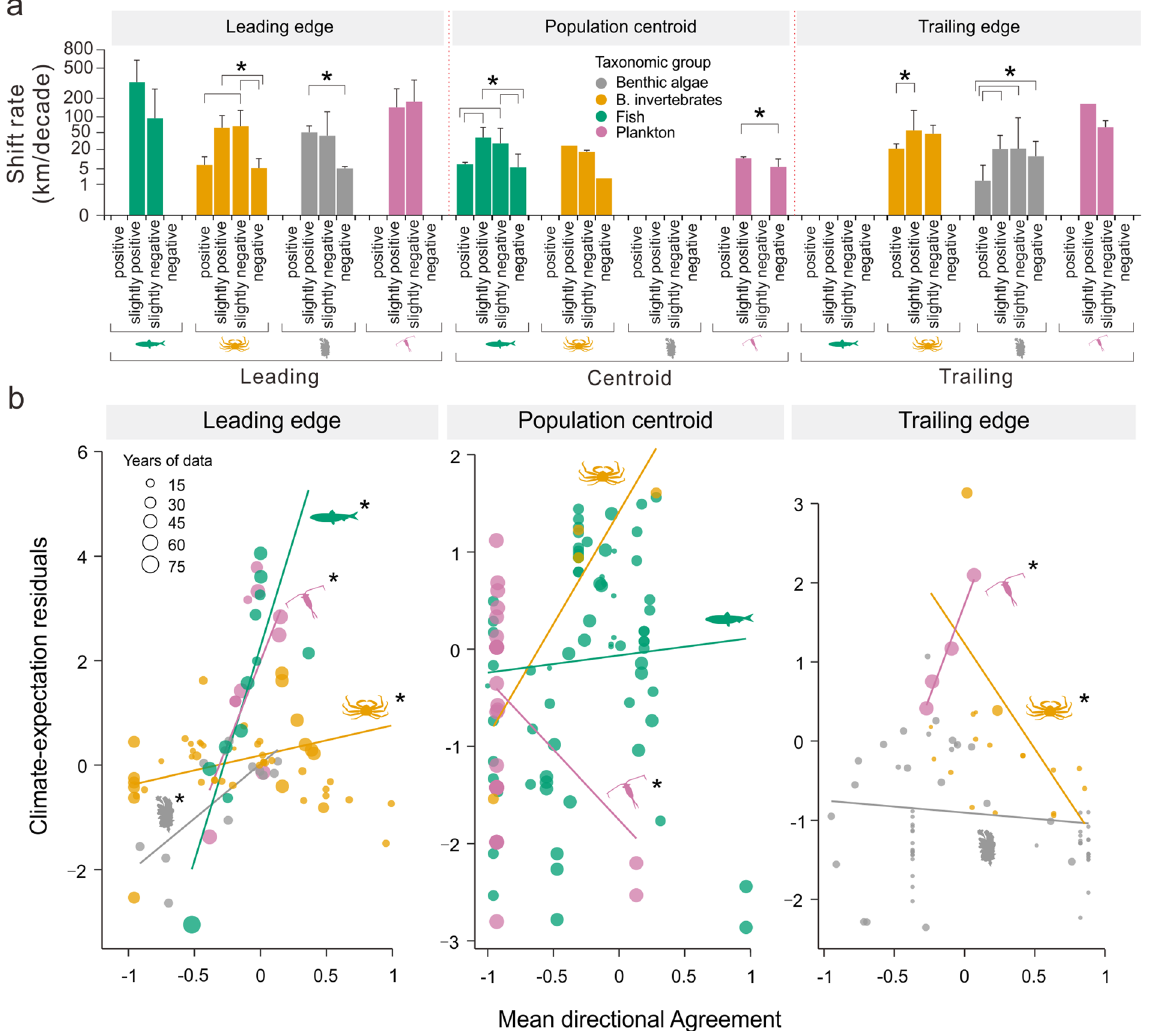
Figure 3. Effect of three-way interactions between directional agreement, taxonomic identity and the location of the shift within the species range (leading, centroid or trailing). ( a ) Mean observed shift rate ( + 1 standard deviation) weighted by the number of observed years per shift record and grouped by the three parameters. Directional agreement was categorized into four groups reflecting the strength of the agreement between currents and thermal gradients (cos( π /4) = 0.71; see Fig. 1b): negative [ − 1, − 0.71], slightly negative ( − 0.71, 0], slightly positive (0, 0.71), and positive [0.71, 1]. Pairwise statistically significant differences between agreement categories within each location-taxa combination are denoted by an asterisk (two sample t -tests, α = 0.05). Levels not represented are those for which no data were available. ( b ) Scatterplots of residuals from the climate- expectation model against mean directional agreement by taxonomic group for leading edges, range centroids and trailing edges. Positive/negative residuals suggest observed responses ahead of/lagging behind the mean expected climate response. Lines correspond to the resulting fitted linear regressions weighted by the number of years per observation, with asterisks denoting the statistical significance of slopes ( α =